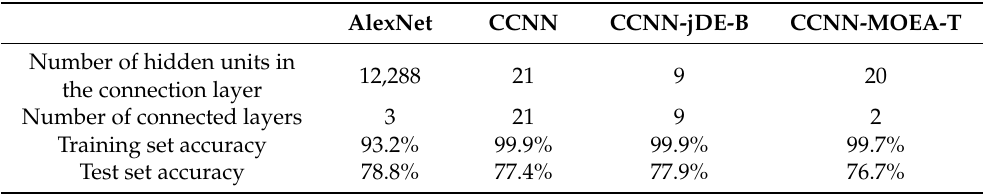
Table 7. The simulation results of the AlexNet pre-training and reconstruction on the CIFAR-10 classification.